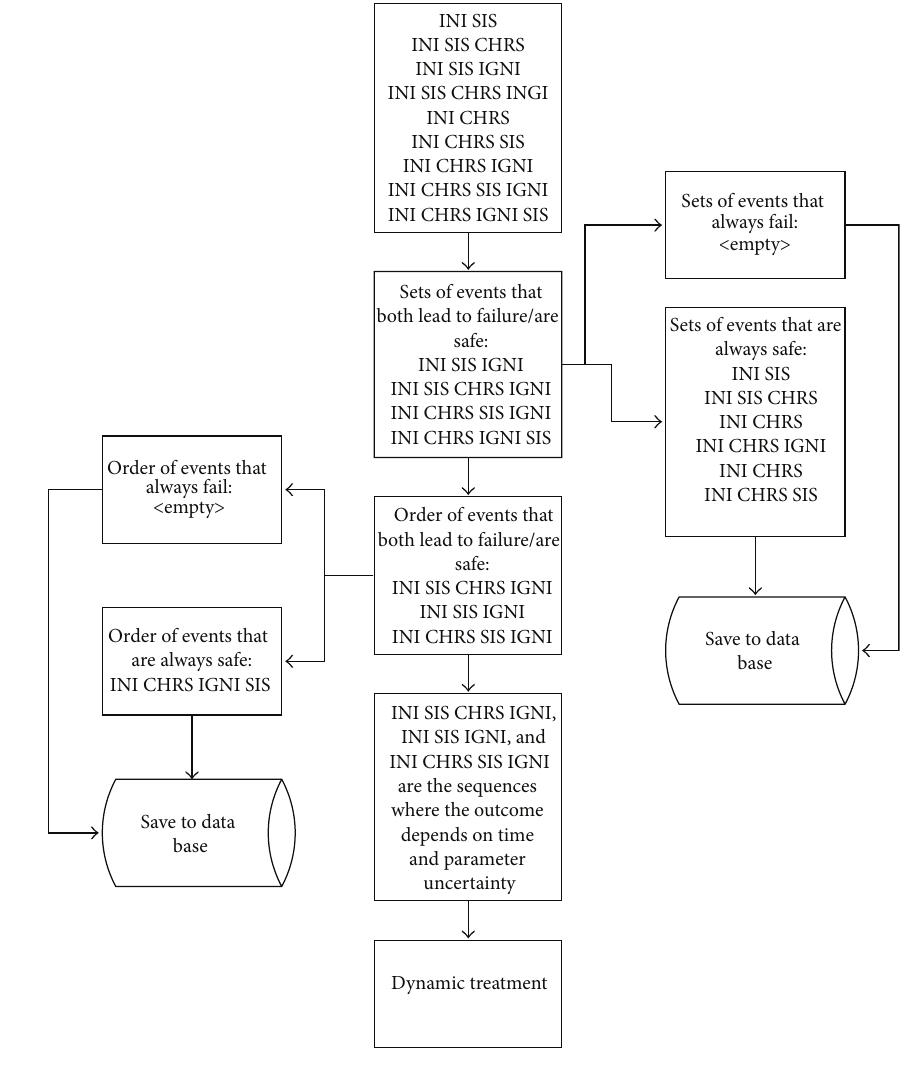
Figure 4: Scenario Grouping.